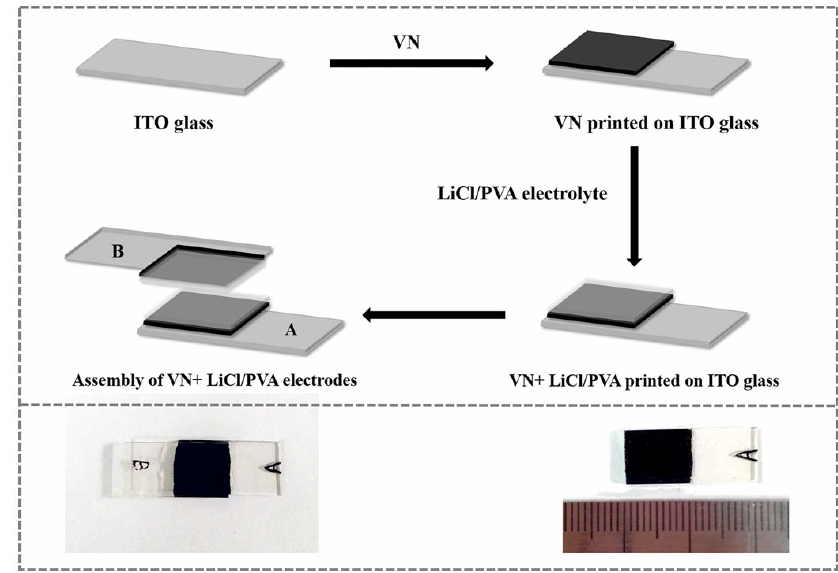
Fig. 5 Overall assembly procedure of VN nanofiber-based all-solid-state